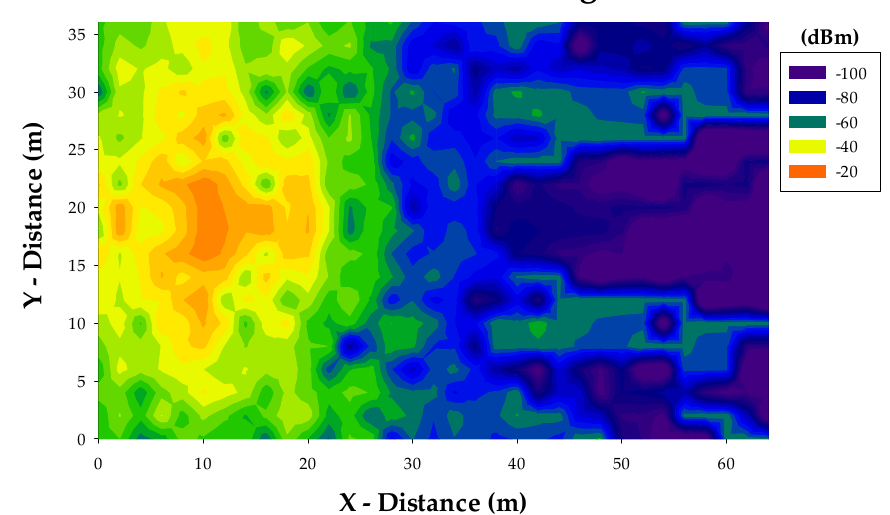
Figure 3. Estimated RF power distributions at height = 5 m for a wireless sensor on the orchard.